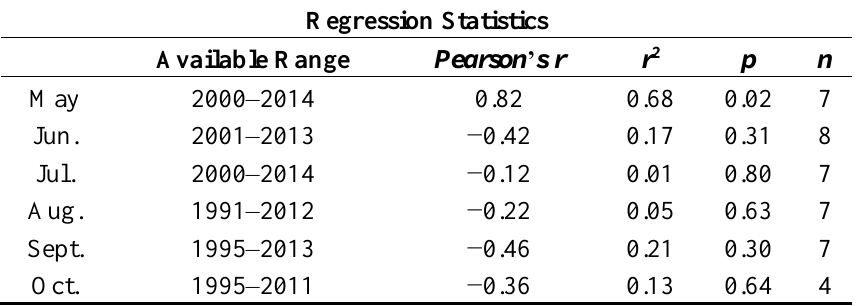
Table 2. Least squares regression statistics for whole-lake mean NTU E by month. Regression Statistics